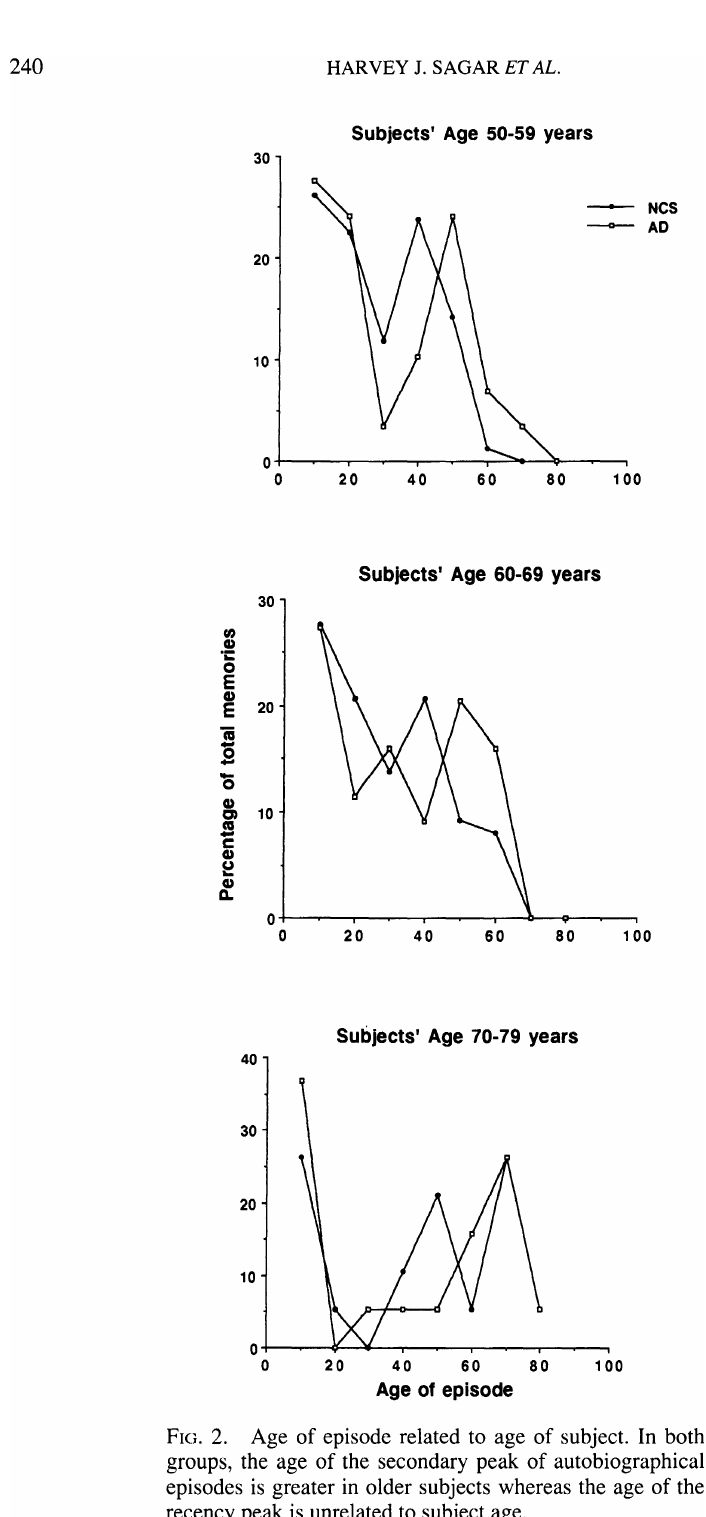
FIG. 2. Age of episode related to age of subject. In both groups, the age of the secondary peak of autobiographical episodes is greater in older subjects whereas the age of the recency peak is unrelated to subject